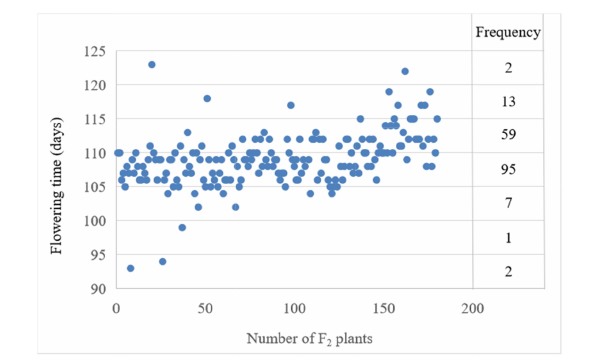
FIGURE 1 | Frequency and distribution of the phenotypic value of the flowering time and frequency in the interval spanning 10 days were labeled on the